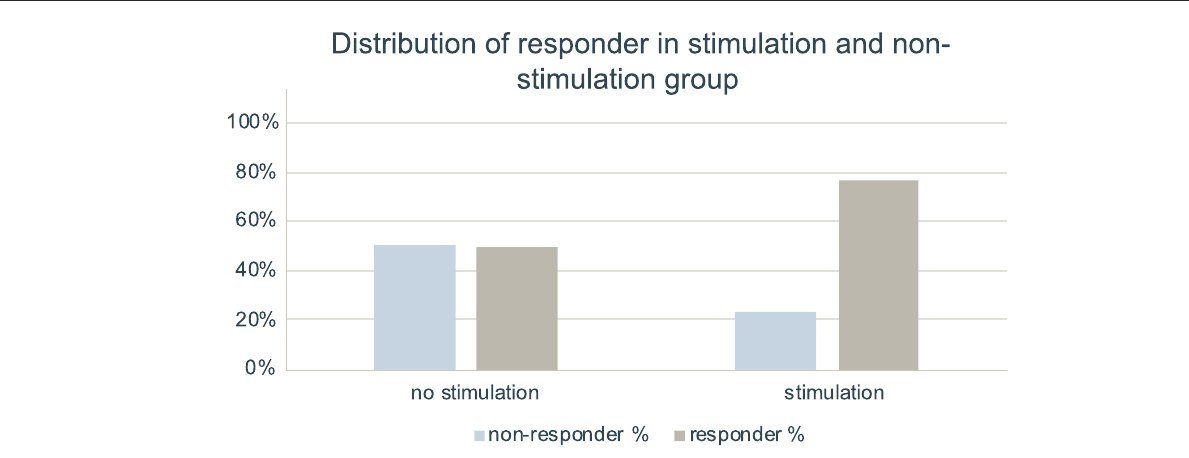
FIGURE4 Distribution of responder in stimulation and non-stimulation setting. Bar charts indicating percentage of responder and non-responder with 50% NRS reduction in group with no stimulation setting ( n = 83) and in group with stimulation setting ( n = 13). Data for infiltration series without stimulation setting was taken from our previous study